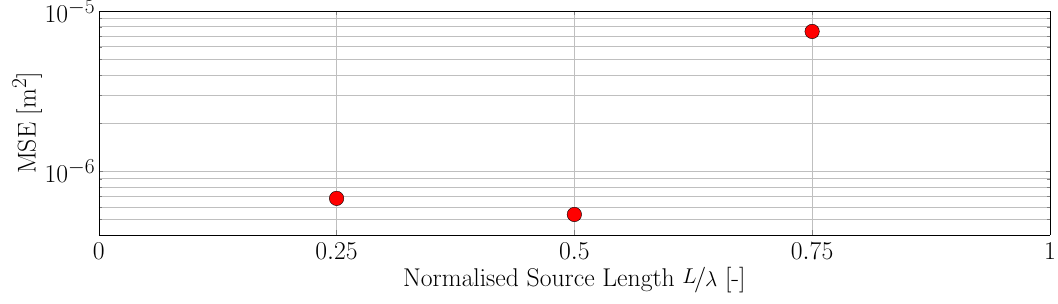
Figure 11. MSE for varying source length. Shallow